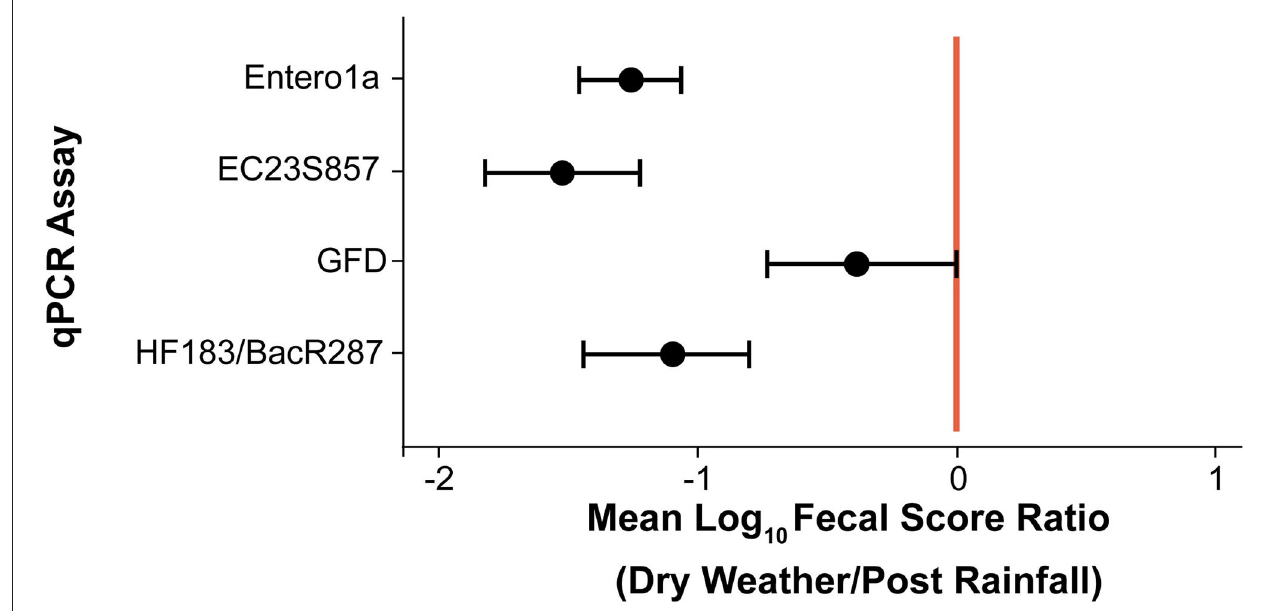
FIGURE 3 | Scatter plot of mean log 10 fecal score ratios (Dry Weather/Post Rainfall) and 95% Bayesian Credible Intervals (BCI) for each qPCR assay. Shaded circles represent mean log 10 fecal score ratios and error bars depict respective 95% BCI. Vertical red line denotes a log 10 fecal score ratio of zero. Mean log 10 fecal score ratio values to the left of red line with no interval overlap indicate scenarios of given qPCR assay genetic marker average log 10 concentration significantly higher after rainfall (post